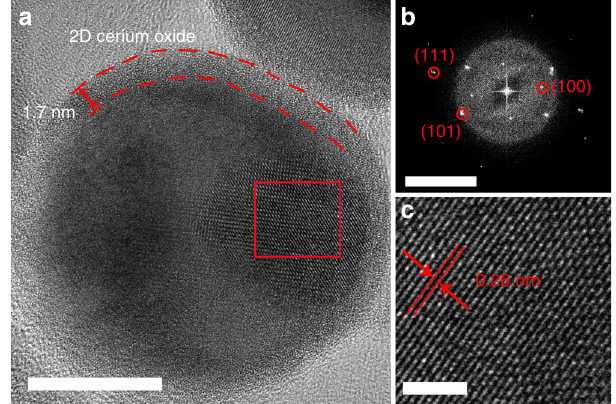
Fig. 4 Characteristics of cerium oxide nanoparticles. a TEM image of a LMCe3% nanodroplet featuring encapsulated solid elemental cerium nanoparticles and an atomically thin layer of cerium oxide (scale bar, 10 nm). b FFT image of the crystalline section (scale bar 5 1/nm). c HRTEM image, the lattice parameters were indexed to elemental cerium (scale bar 2 nm)